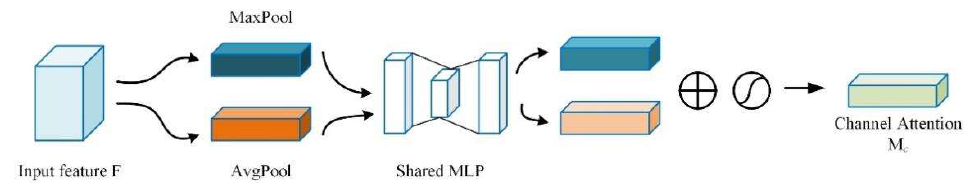
Figure 6. Schematic diagram of the structure of the channel attention model.